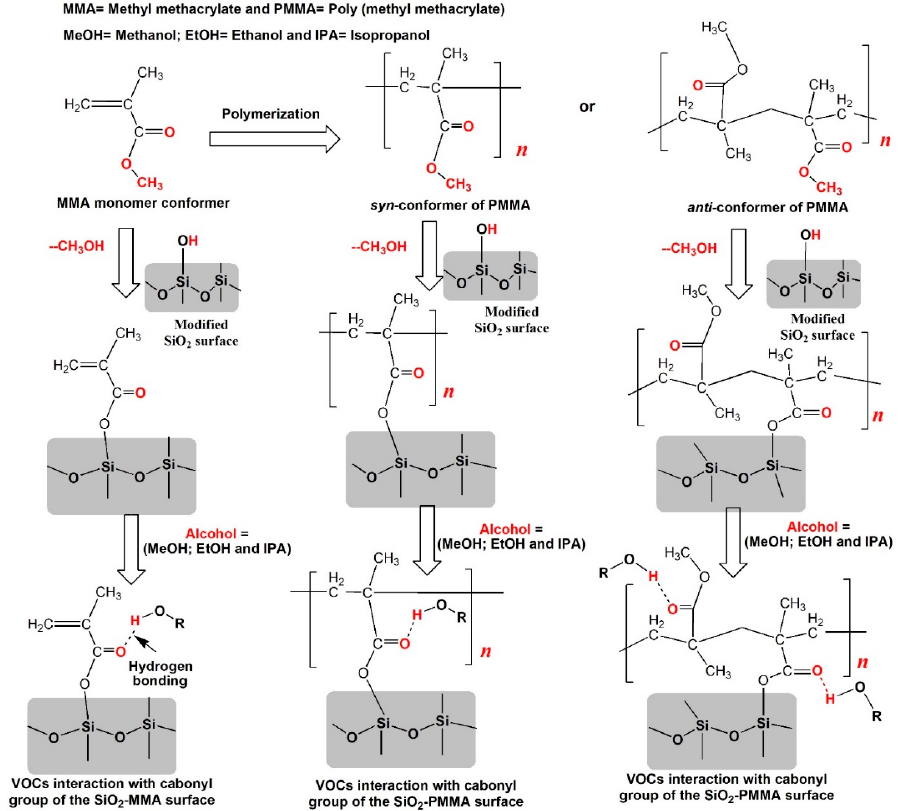
Figure 2. Proposed hypothetical steps for the coating of PMMA onto the MCL surfaces and the binding mode (via hydrogen bonding) of the VOCs with the PMMA.